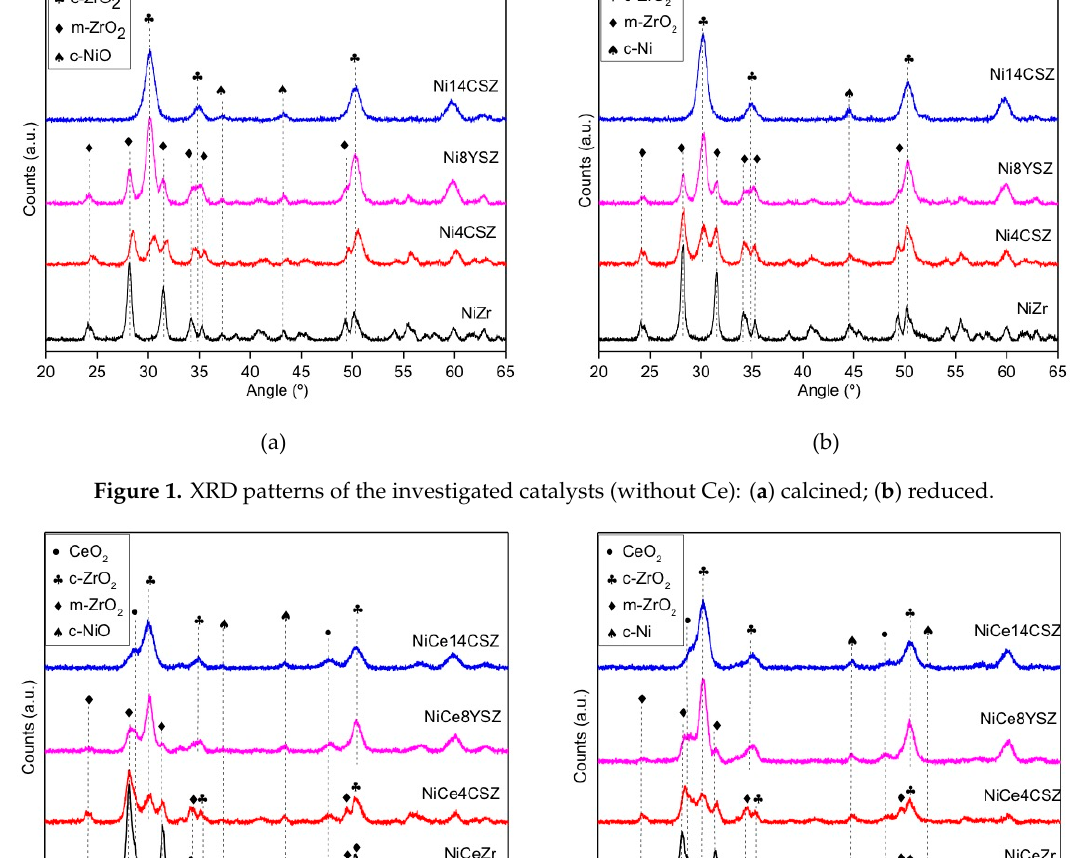
Figure 1. XRD patterns of the investigated catalysts (without Ce): ( a ) calcined; ( b ) reduced.